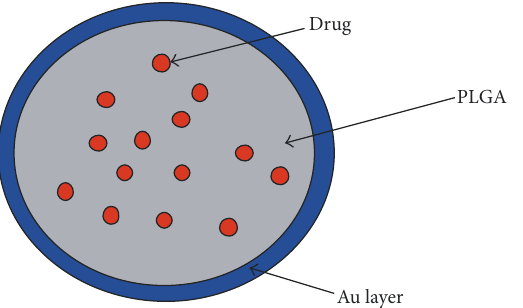
Figure 6: Schematic diagram of DOX-PLGA-Au (the is figure based on [149]).